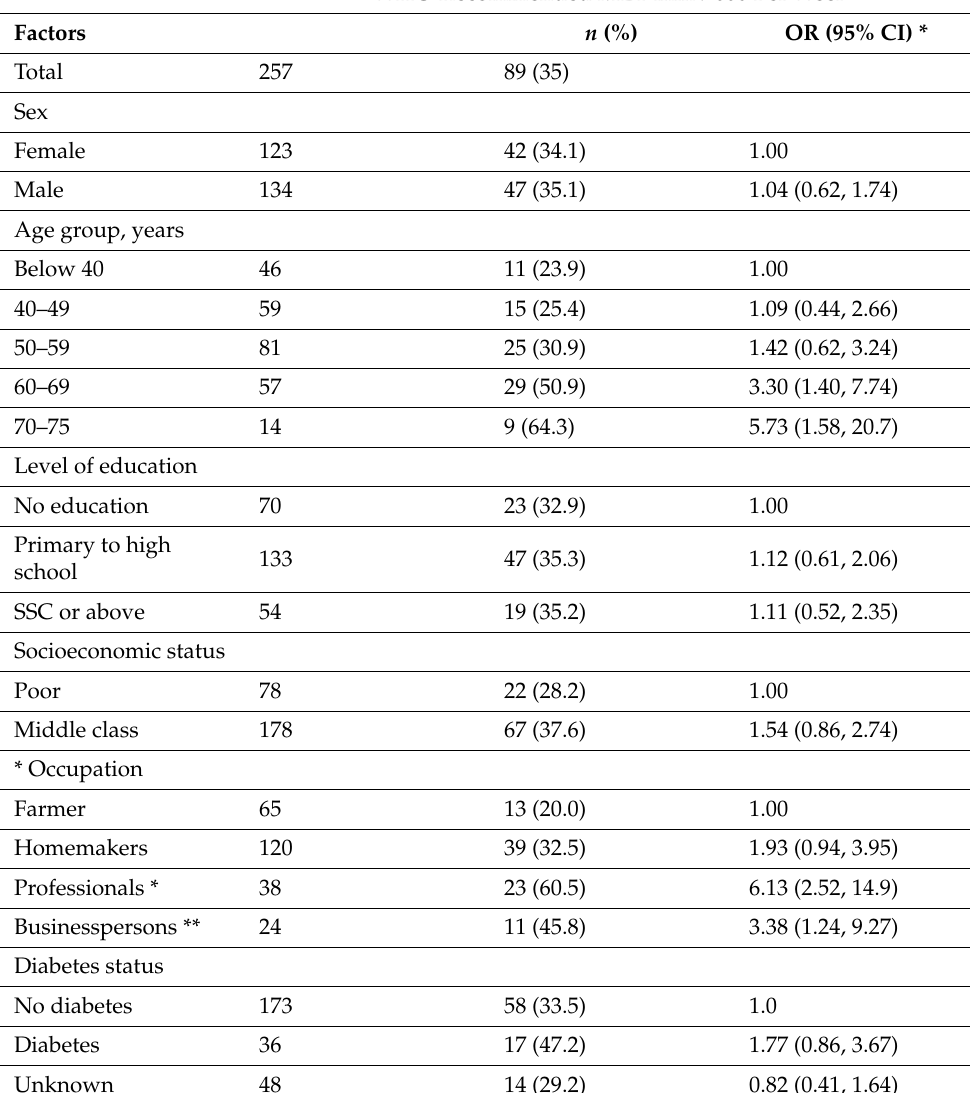
Table 3. Association of sociodemographic factors with false negative physical activity levels of 257 physically active